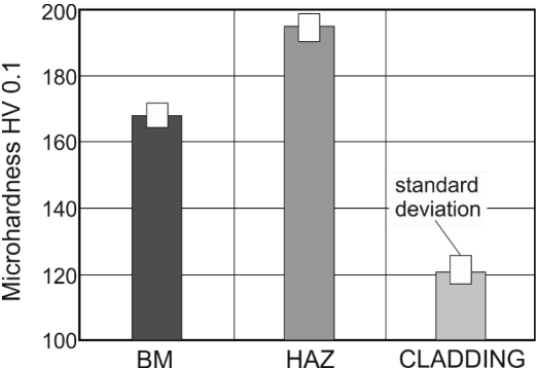
Figure 12. Microhardness (HV 0.1) values measured in different regions (BM: base material, HAZ: heat-affected zone).